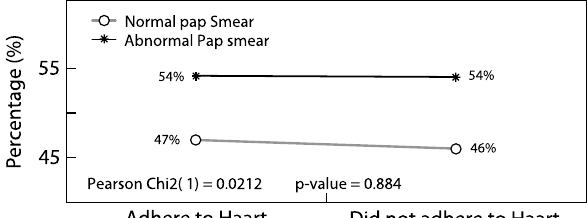
Figure 3: Association between the adherence to HAART with abnormal Pap